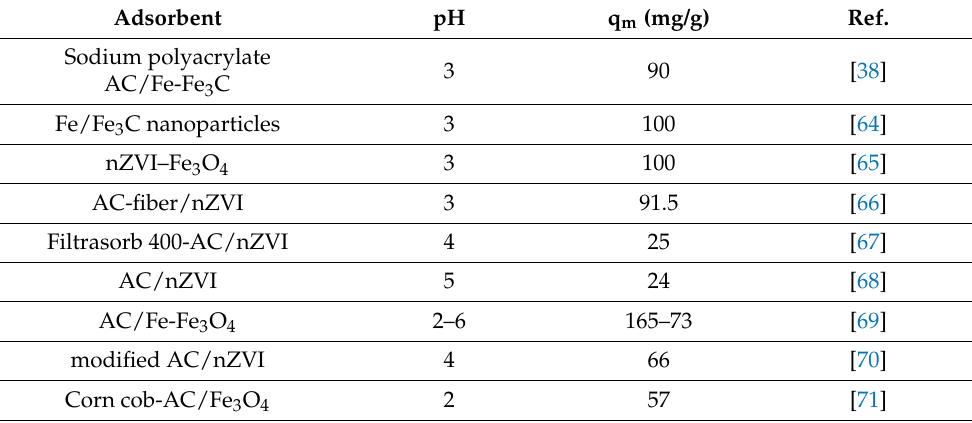
Table 6. Comparison of the Cr(VI) adsorption capacities (q m ) on mAC-snack with other adsorbents reported in the